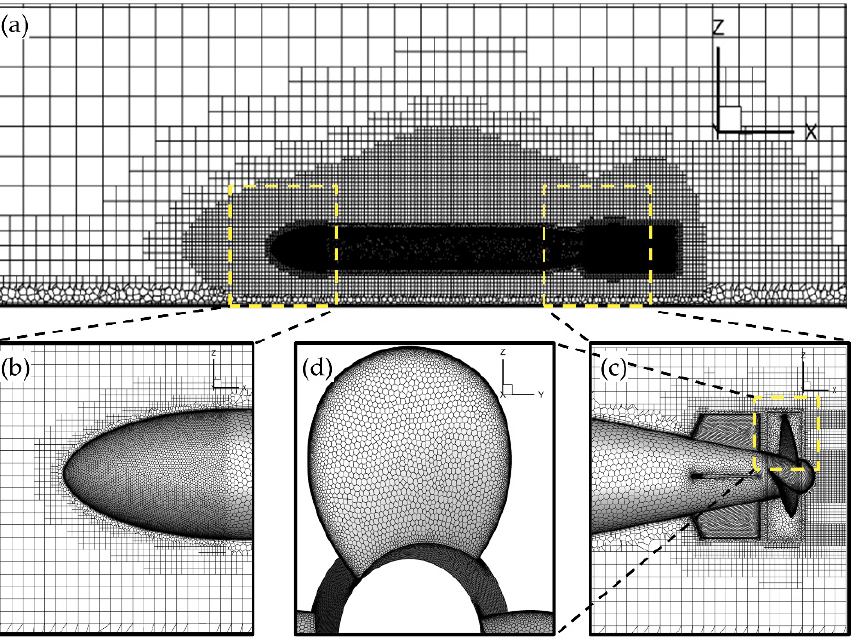
Figure 3. Grid settings. ( a ) The longitudinal profile grid of the domain with HD of 1.5; ( b ) UUV nose grid; ( c ) UUV tail grid; ( d ) propeller grid.